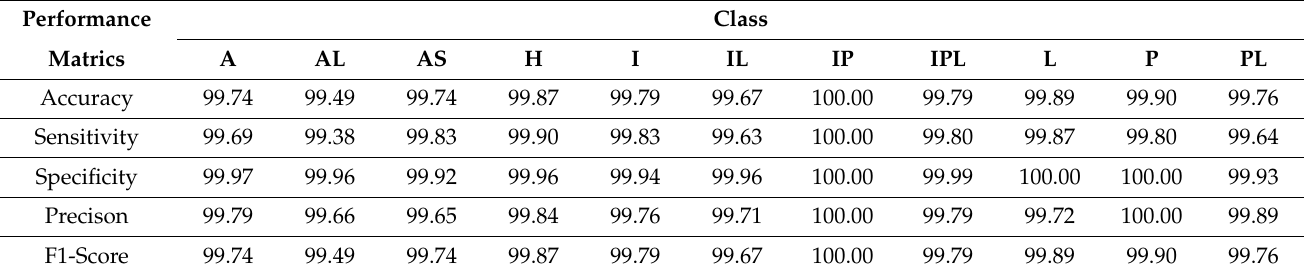
Table 5. Performance Metrics (%) 10 MI and Normal